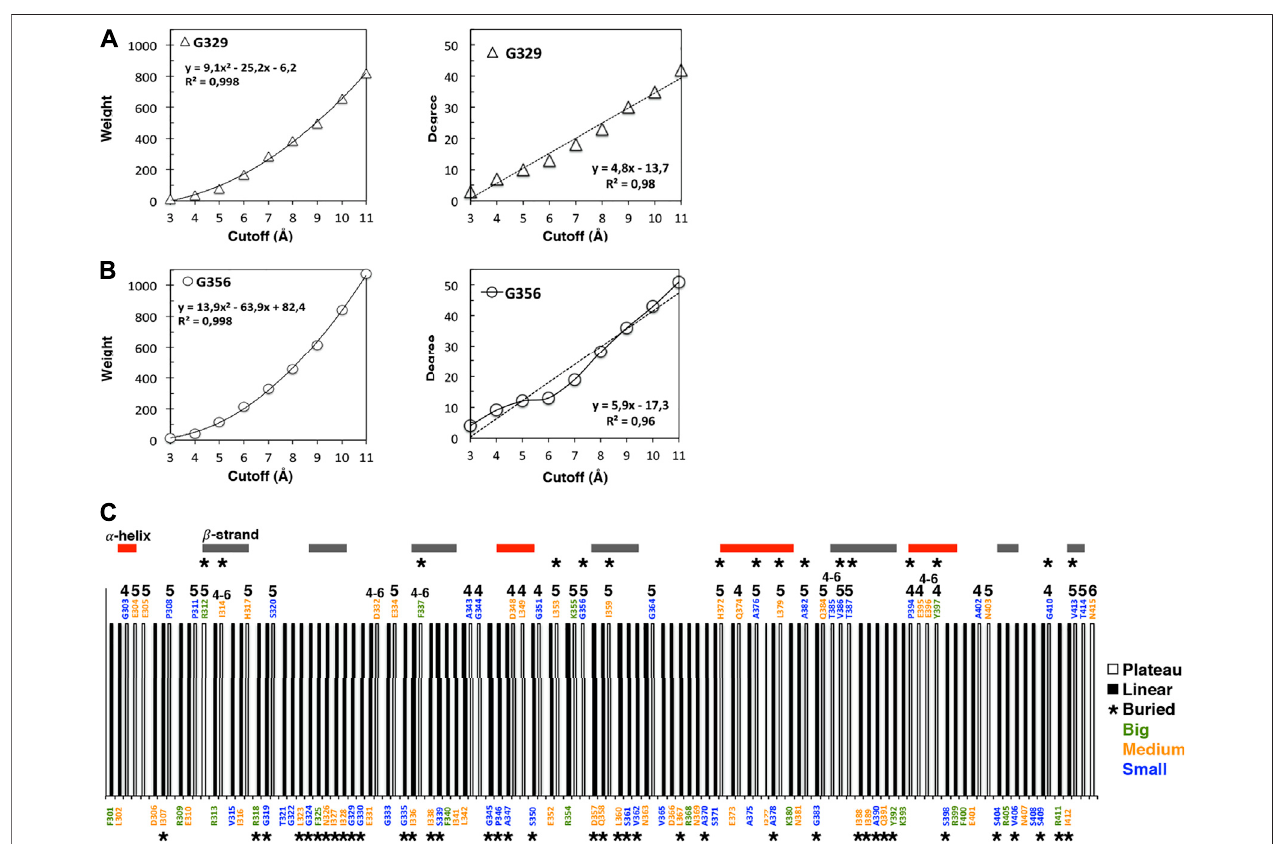
FIGURE1| CutoffdependenciesoftheweightandthedegreeoftheAANnodesofthe1BE9structure. (A) Examplesoftheweightcutoffdependenciesforglycine, thesmallestaminoacid.Theincreaseisquadratic(R2 ∼ 1). (B )Exampleofthedegreecutoffdependenciesforthesameaminoacids.Oneislinear(R2 ∼ 0,98, toppanel ), and the other has a plateau between cutoffs 5 and 6 Å (bottom panel) . (C) 1D-barcode: cutoff dependencies of the 1BE9 sequence. The amino acids are colored according to the length of their extended side chains (blue: length < 3 Å, orange: 3 Å ≤ length < 5 Å, and green: length ≥ 5 Å). The colored horizontal bars represent thesecondarystructuresalongthesequence.Thestarisforburiedaminoacids,andthenumbersindicatethecutoffrangeoftheplateau:fourisforaplateauatcutoffs4 to 5 Å, 5 is for plateau at cutoffs fi ve to 6 Å, six is for a plateau at cutoffs 6 to 7 Å and four – six is for a plateau at cutoffs 4 to 6 Å.